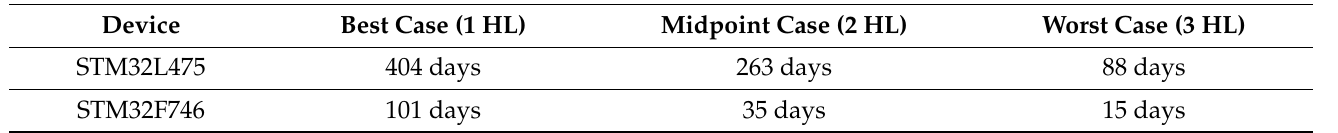
Table 2. Estimated battery life for a Li-SOCL2(A3400) battery when performing 10 classifications per second with the studied microcontrollers and FIQ network